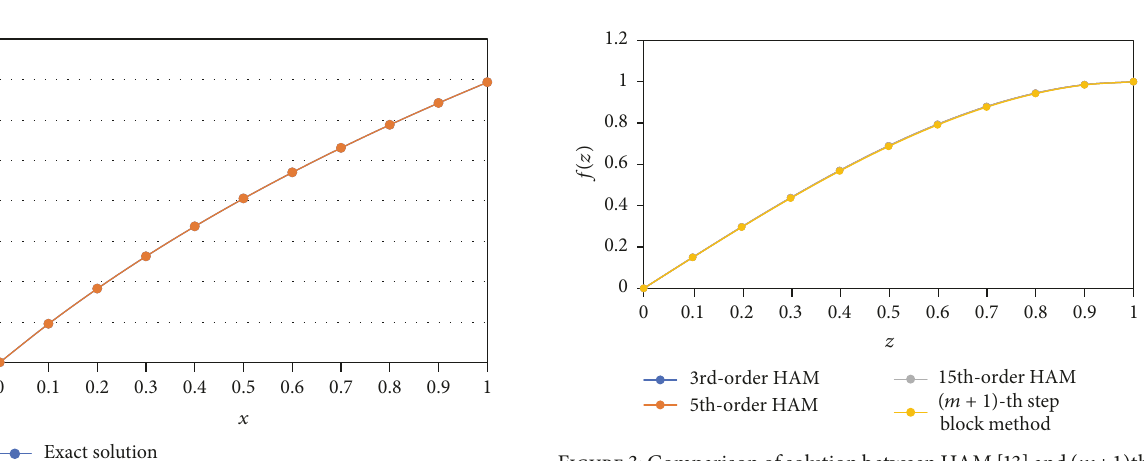
Figure 3: Comparison of solution between HAM [13] and (𝑚+1) th- step block